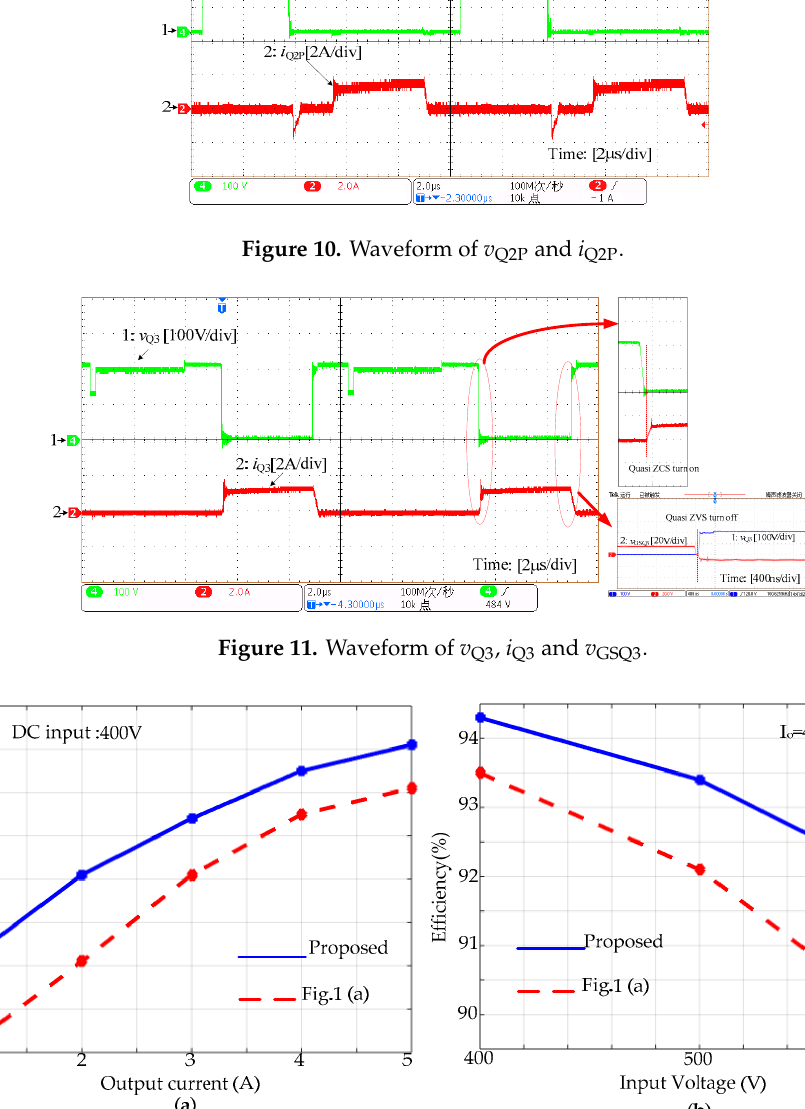
ffi ciency curves: ( a ) V = 400 V, I = 4 A, V o is varied; ( b ) I o Figure 12. Efficiency curves: ( a ) V in = 400 V, I o is varied; ( b ) I o = 4 A, V in is varied. Figure 12. E in in is Figure 12. Efficiency curves: ( a ) V in = 400 V, I o is varied; ( b ) I o = 4 A, V in is varied. Figure 12. Efficiency curves: ( a ) V in = 400 V, I o is varied; ( b ) I o = 4 A, V in is varied.